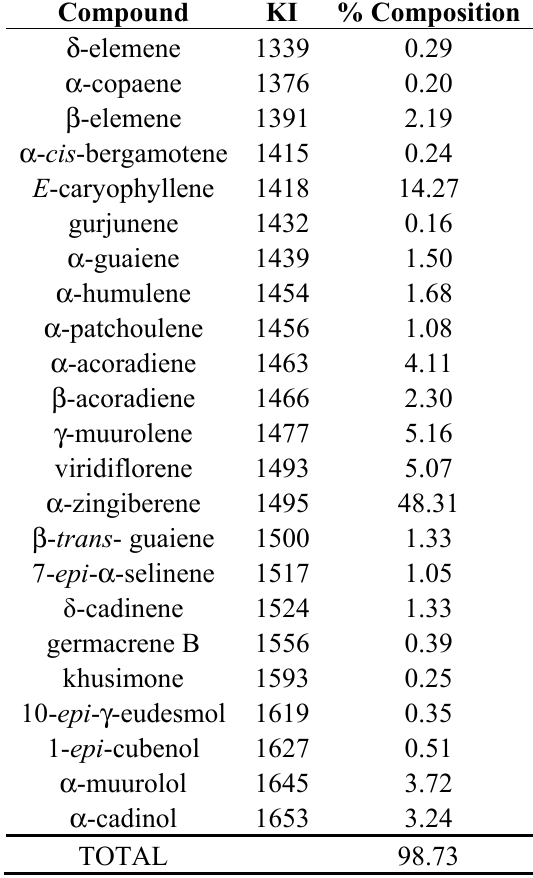
Table 1. Chemical composition of the essential oil from leaves of C. sylvestris